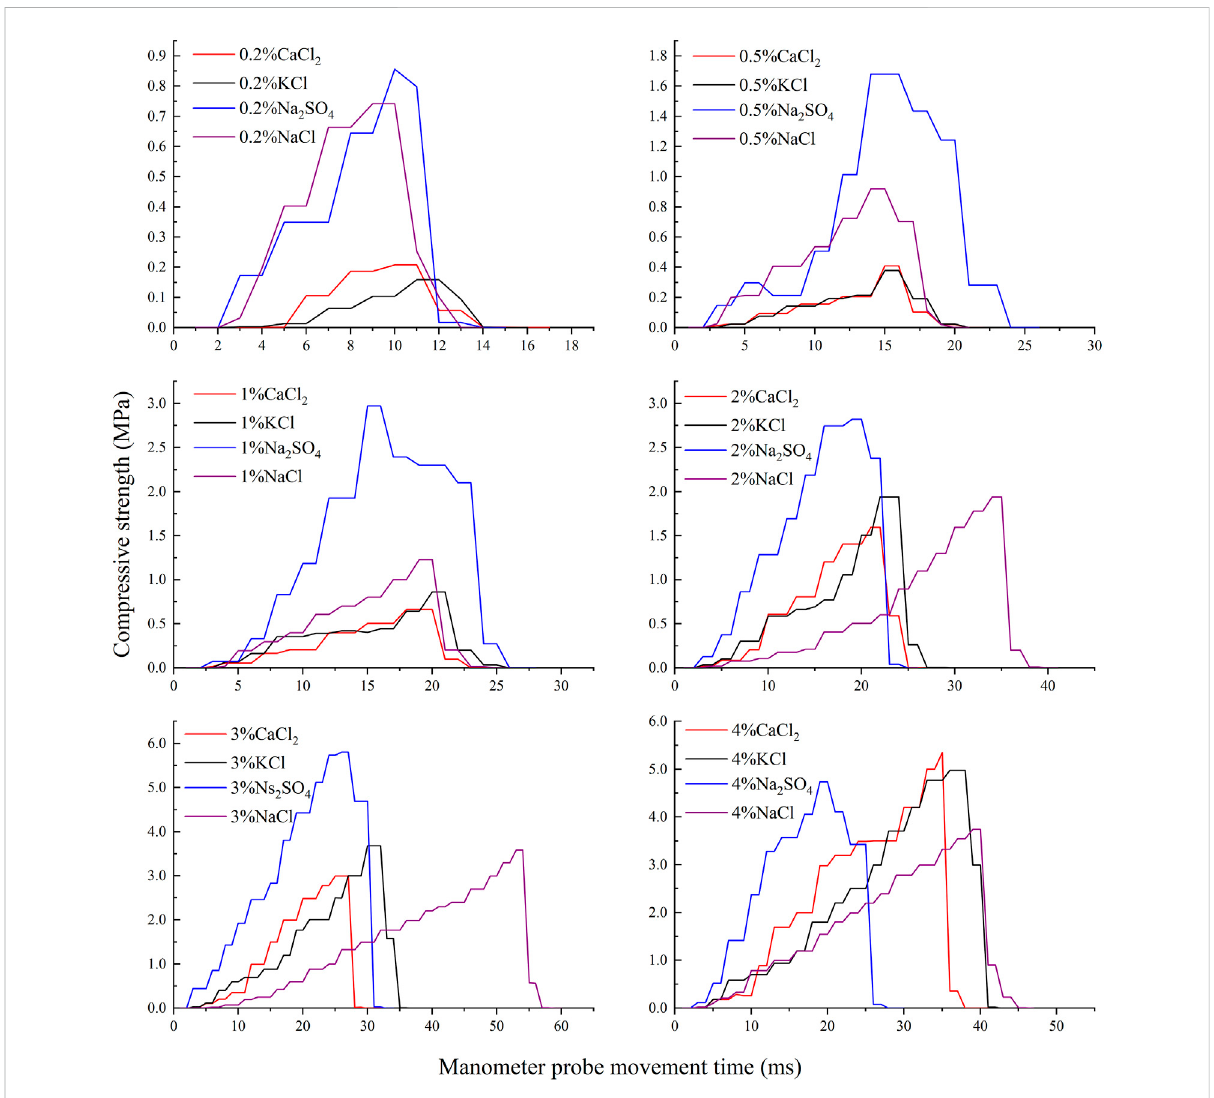
FIGURE 4 Stress-time curves of four salts with different salt